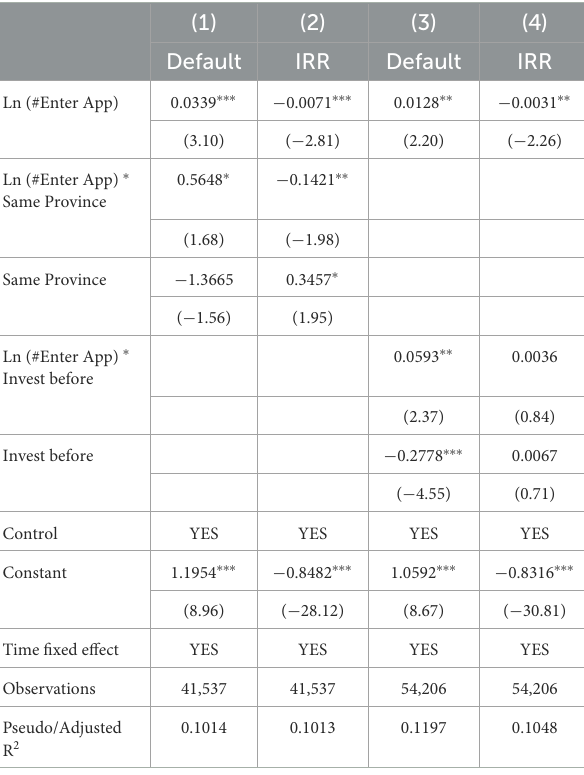
TABLE 6 Mechanism analysis: from the perspective of the information process.